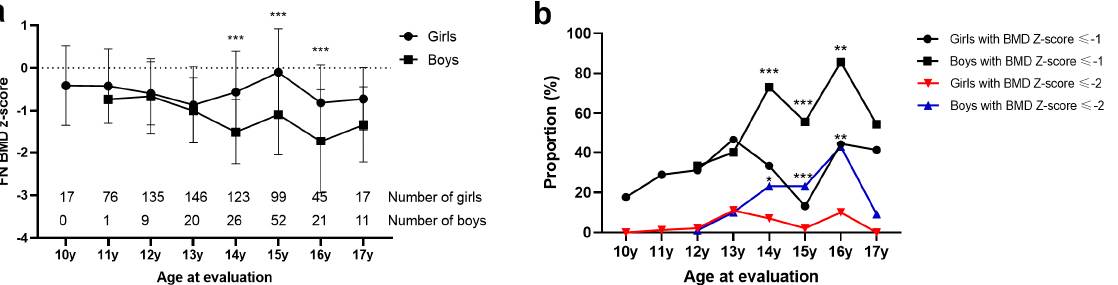
Table 2. Univariate assessment for low BMD (Z-score ≤ − 2 and Z-score ≤ − 1) in patients with